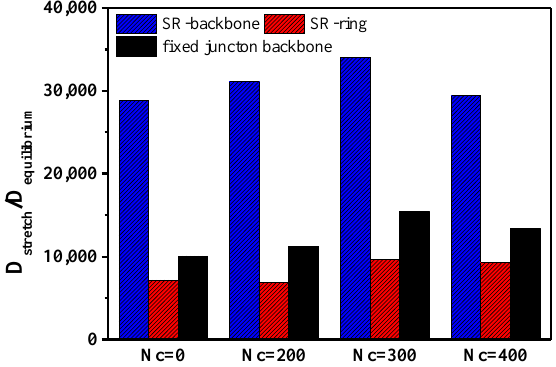
Figure 10. The comparison of D stretch / D equilibrium between different motional units in SR systems and fixed junction systems. The diffusion coefficients are derived from linear fitting on the MSD curves under stretch and equilibrium without deformation.